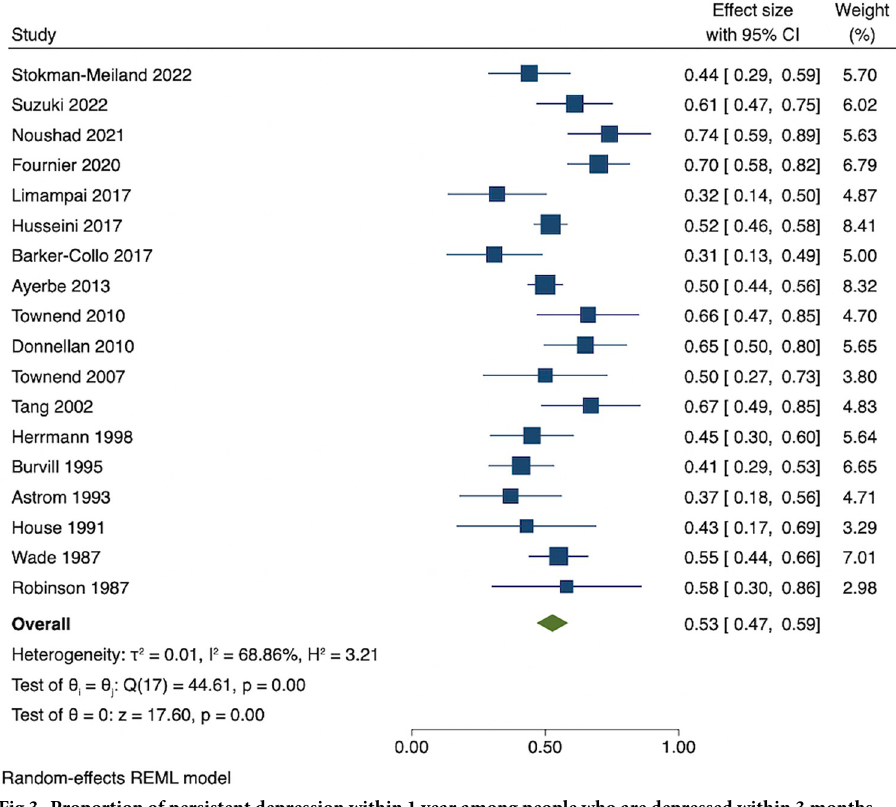
Fig 3. Proportion of persistent depression within 1 year among people who are depressed within 3